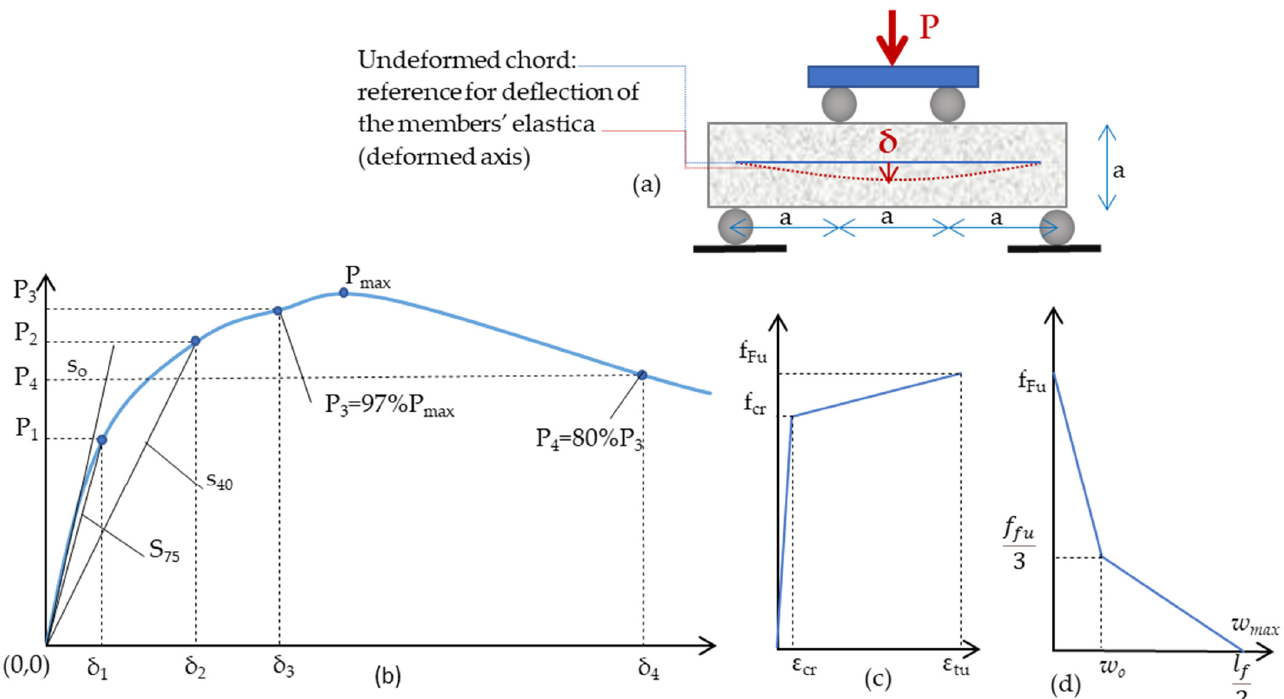
Figure 9. ( a ) Third Point Loading of Prism to obtain the resistance curve shown in ( b ) and from there, through inverse analysis, the stress–strain curve shown in ( c ) and the stress–crack opening displacement in ( d ).